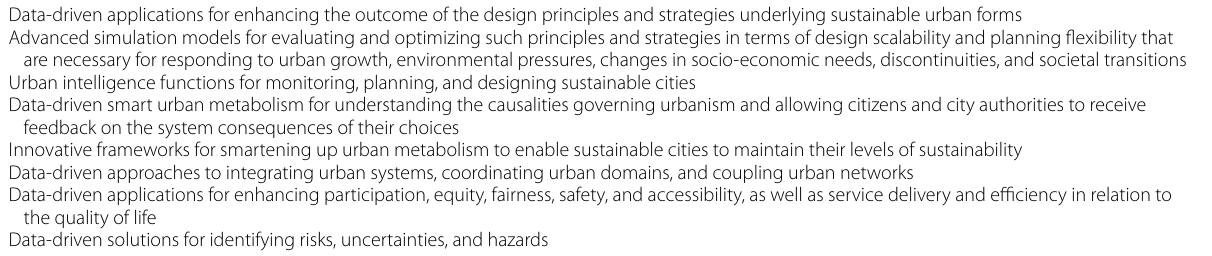
Table 2 Benefits of smart cities for sustainable cities Data-driven applications for enhancing the outcome of the design principles and strategies underlying sustainable urban forms Advanced simulation models for evaluating and optimizing such principles and strategies in terms of design scalability and planning flexibility that are necessary for responding to urban growth, environmental pressures, changes in socio-economic needs, discontinuities, and societal transitions Urban intelligence functions for monitoring, planning, and designing sustainable cities Data-driven smart urban metabolism for understanding the causalities governing urbanism and allowing citizens and city authorities to receive feedback on the system consequences of their choices Innovative frameworks for smartening up urban metabolism to enable sustainable cities to maintain their levels of sustainability Data-driven approaches to integrating urban systems, coordinating urban domains, and coupling urban networks Data-driven applications for enhancing participation, equity, fairness, safety, and accessibility, as well as service delivery and efficiency in relation to the quality of life Data-driven solutions for identifying risks, uncertainties, and